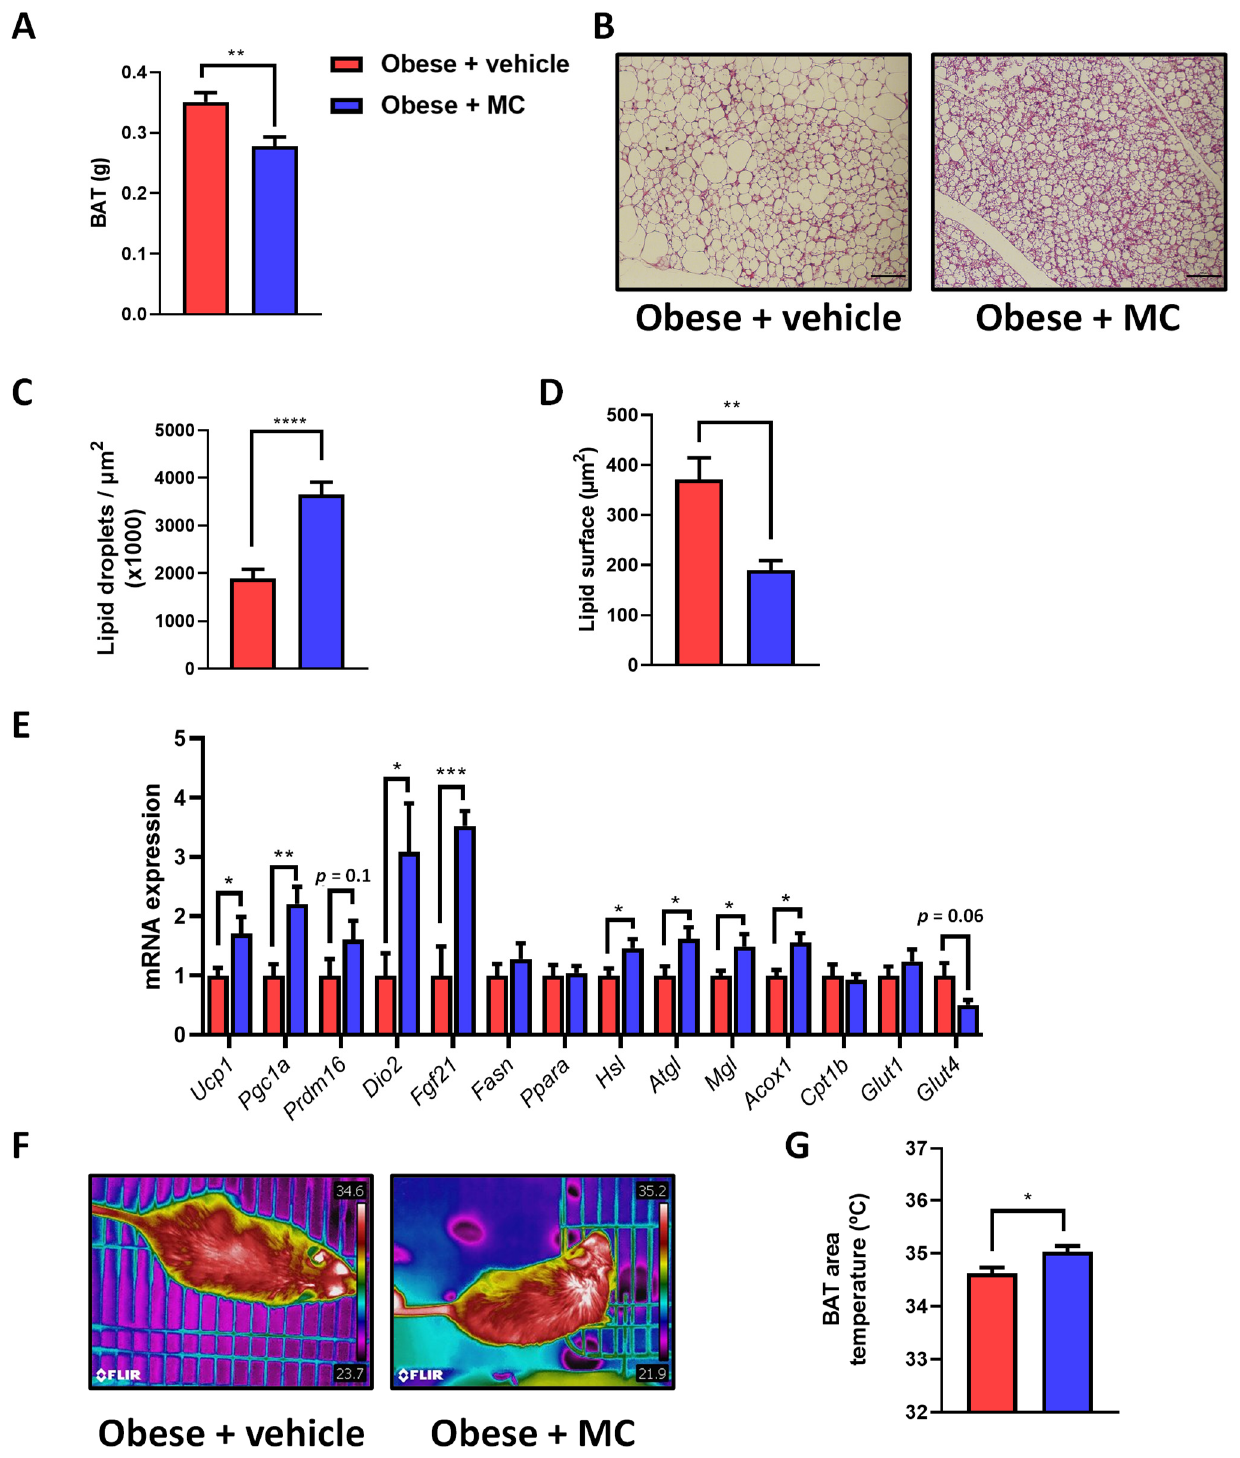
Figure 4. MC supplementation increases BAT thermogenesis. Effects of treatments on: ( A ) brown adipose tissue (BAT) weight; ( B ) representative micrographs of hematoxylin–eosin-stained BAT sections (Bar = 100 µm); ( C ) lipid droplets, and ( D ) and quantification of the lipid droplet surface. ( E ) BAT mRNA expression of genes related to BAT function ( Ucp1 , Pgc1a , Prdm16 , Dio2 , and Fgf21 ); de novo lipogenesis ( Fasn and Ppara ); lipolysis ( Hsl , Atgl and Mgl ); fatty acid oxidation ( Acox and Cpt1b ); and glucose uptake ( Glut1 and Glut4 ). ( F , G ) Representative thermographic images of the BAT skin area and quantification. Data are mean ± SEM. * p < 0.05, ** p < 0.01, *** p < 0.001, **** p <